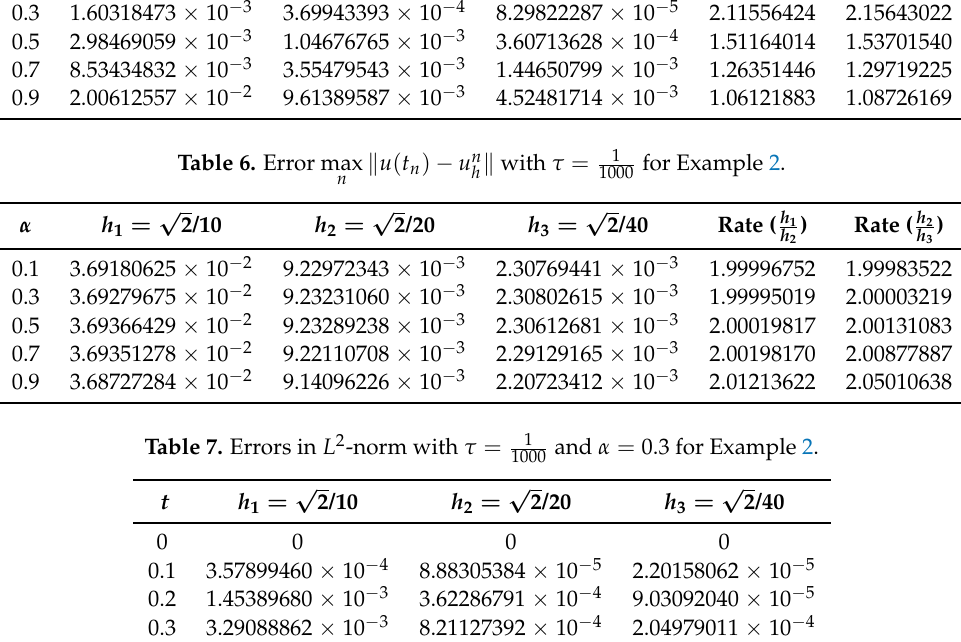
(cid:107) with h = h